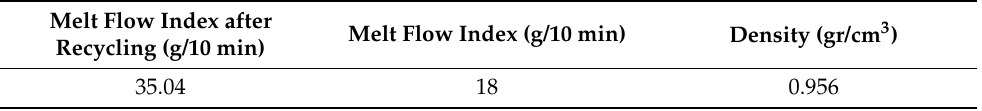
Table 1. Specifications of polyethylene.